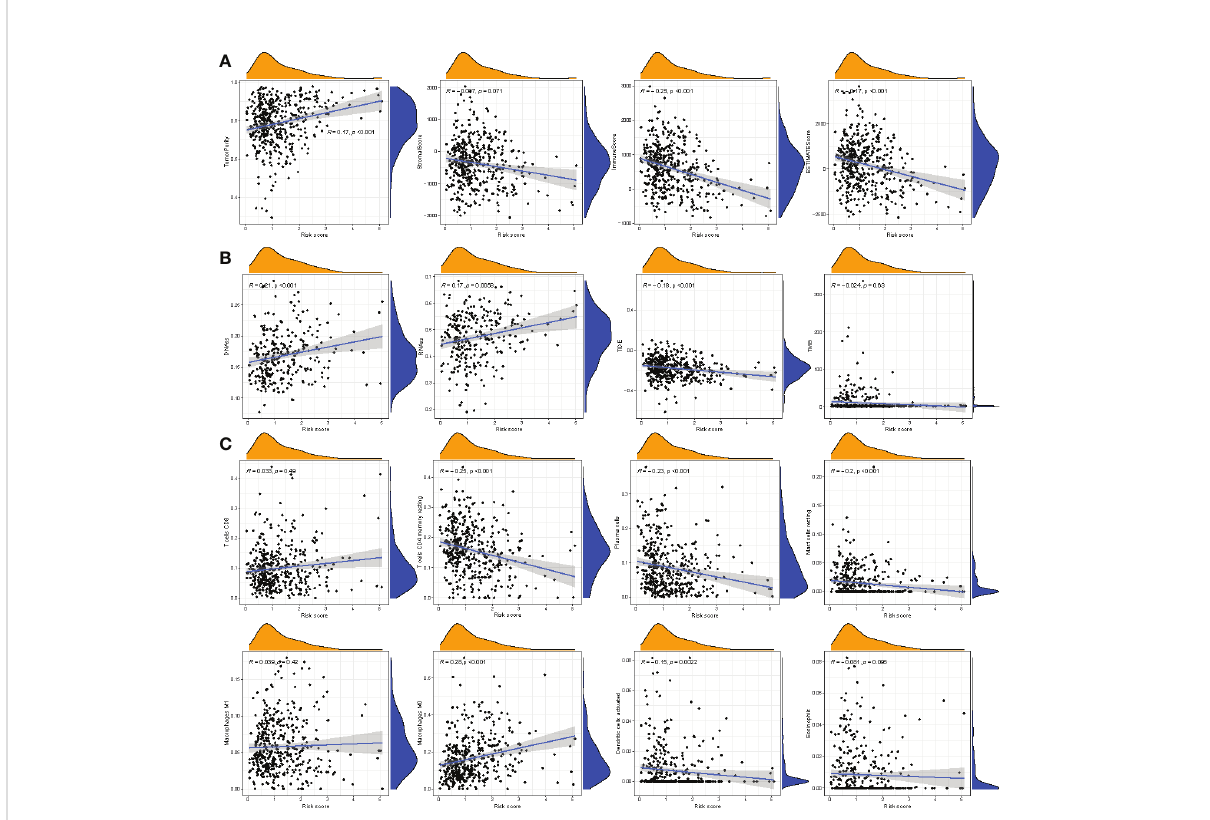
FIGURE 8 Correlation between riskscore and other scores. (A) Correlation between riskscore and tumor immune microenvironment. (B) Correlation between riskscore and stem cell scores, TIDE, tumor mutation burden. (C) Correlation between riskscore and immune cell in fi ltration-related